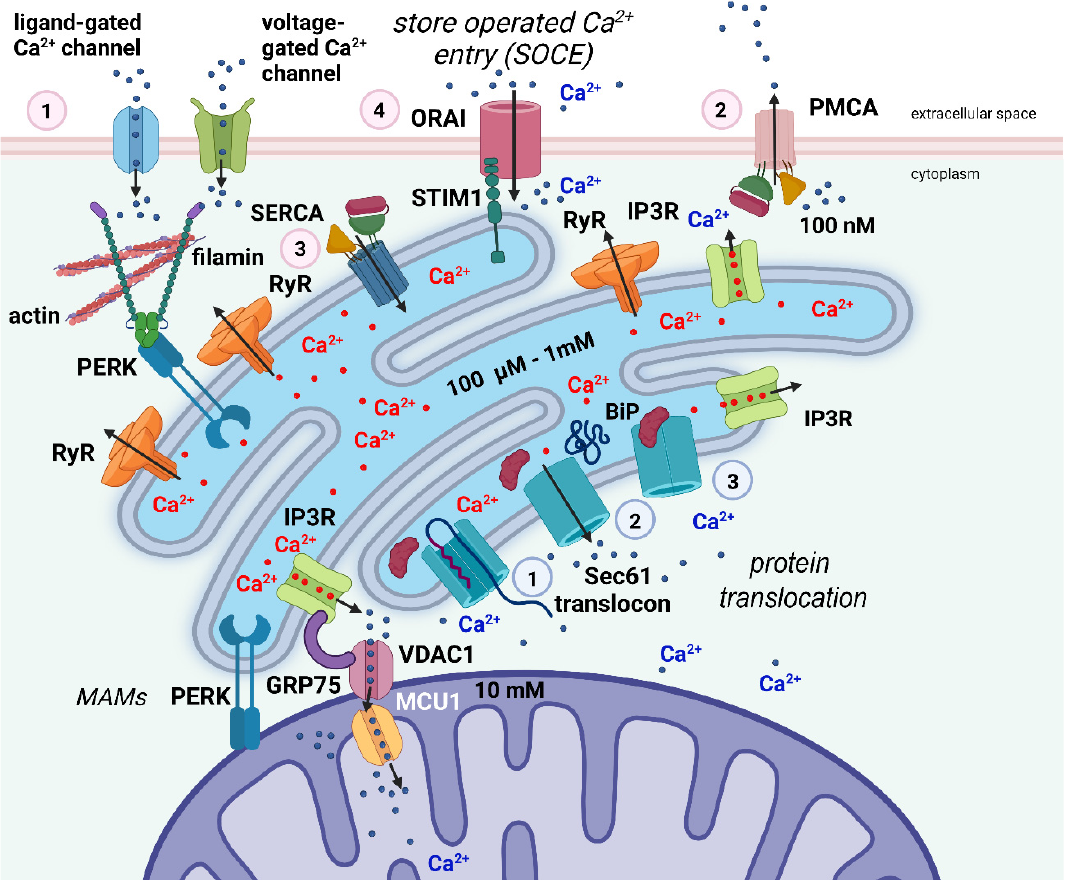
Figure 2. Simplified scheme of Ca 2+ dynamics inside the cell and its relation to ER stress. In excitable cells such as neurons, Ca 2+ ions enter the cell through ligand-gated and voltage-gated channels (1—pink circle). The Ca 2+ gradient across the cell membrane is actively maintained by the PMCA pump (2—pink circle). The ER is the main Ca 2+ -storing organelle. Ca 2+ is transported against a steep concentration gradient into the lumen of the ER via the SERCA pump (3—pink circle). Upon ligand stimulation, Ca 2+ ions are released from the reticulum into the cytosol via the IP3Rs and RyRs to activate Ca 2+ -dependent proteins and mediate stimulus-response signaling. The refilling of intracellular Ca 2+ stores by extracellular Ca 2+ occurs via SOCE (4—pink circle) by close apposition of the transmembrane proteins STIM1 and ORAI. Filamin A, an actin-binding protein, interacts with PERK independently from the UPR. This interaction seems to be crucial for the formation of juxtapositions of the ER membrane with the plasma membrane, the proximity of the two membranes being a precondition for SOCE to occur. Protein translocation across the ER membrane is mediated via the Sec61 translocon (1—light blue circle). At the end of the translocation process, the Sec61 channel mediates the efflux of Ca 2+ from the ER to the cytosol resulting in a reduction in [Ca 2+ ] ER (2—light blue circle). The ER chaperone BiP binds to the translocon to close it and block the Ca 2+ efflux from the ER (3-light blue circle). Efficient Ca 2+ flux from the ER to mitochondria is mediated via IP3Rs, the voltage-dependent anion channel 1 (VDAC1), which is located at the outer mitochondrial membrane, and mitochondrial Ca 2+ uniporter 1 (MCU1), located at the inner mitochondrial membrane. The IP3Rs–VDAC1 interaction is facilitated by the chaperone GRP75, which is enriched in MAMs. Created with biorender.com (www.biorender.com, accessed on 27 November